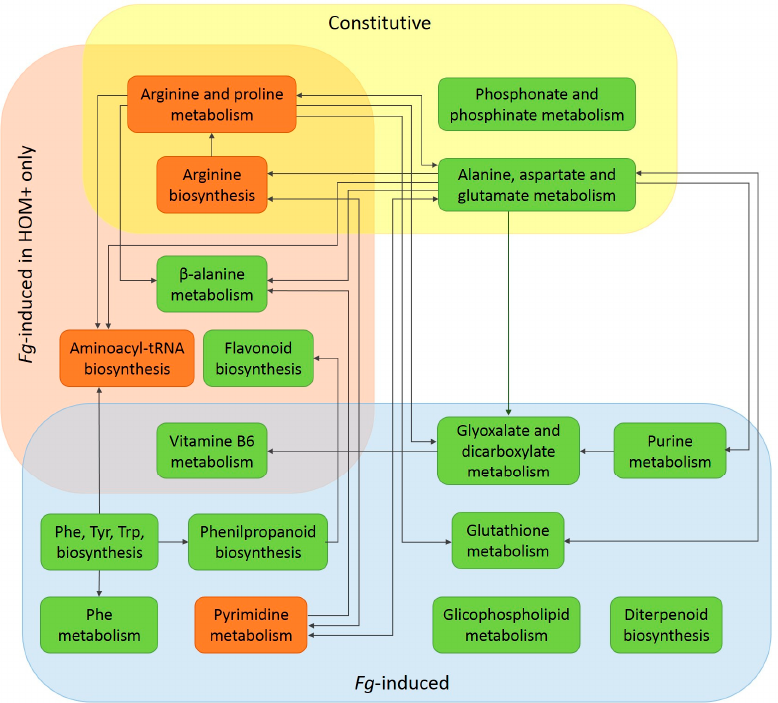
Figure 12. Differentially regulated pathways in rachis of the FHB-resistant HOM+ vs. susceptible HOM − lines at 4 dpi. Red and green squares indicate downregulated and upregulated pathways, respectively, in the HOM+ genotype, as from the comparisons performed and reported in Figures 5 and S1a. Arrows indicate putative crosstalk between pathways in accordance with the KEGG database (Phe, phenylala- nine; Tyr, tyrosine; Trp, tryptophan).